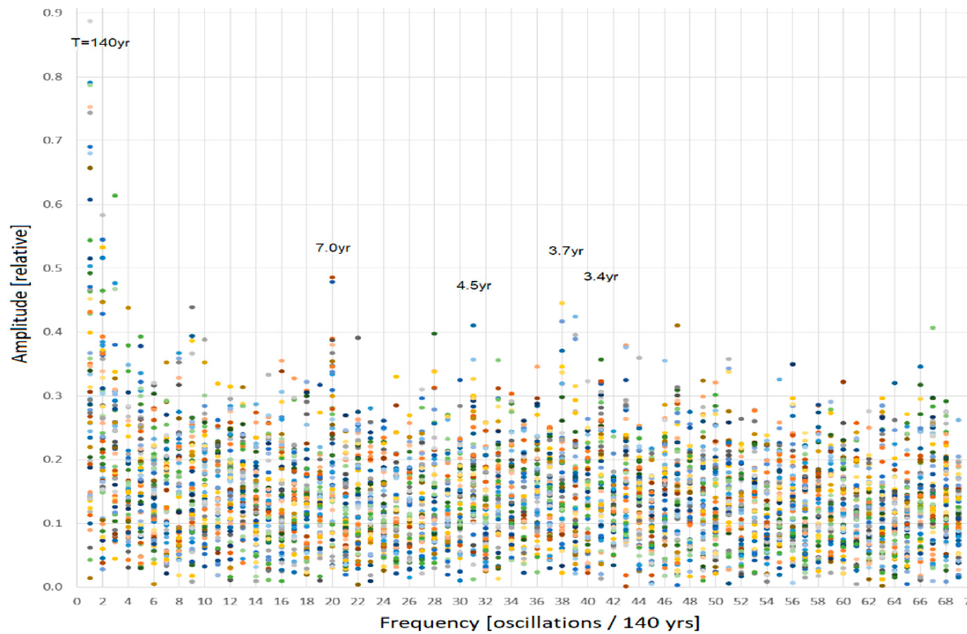
Figure 2. Amplitude (in relative units) of periodic signals for all 60 sites. However, colours here indicate the site and are not for practical identification. The horizontal axis represents frequency; some periods are given above the data points.